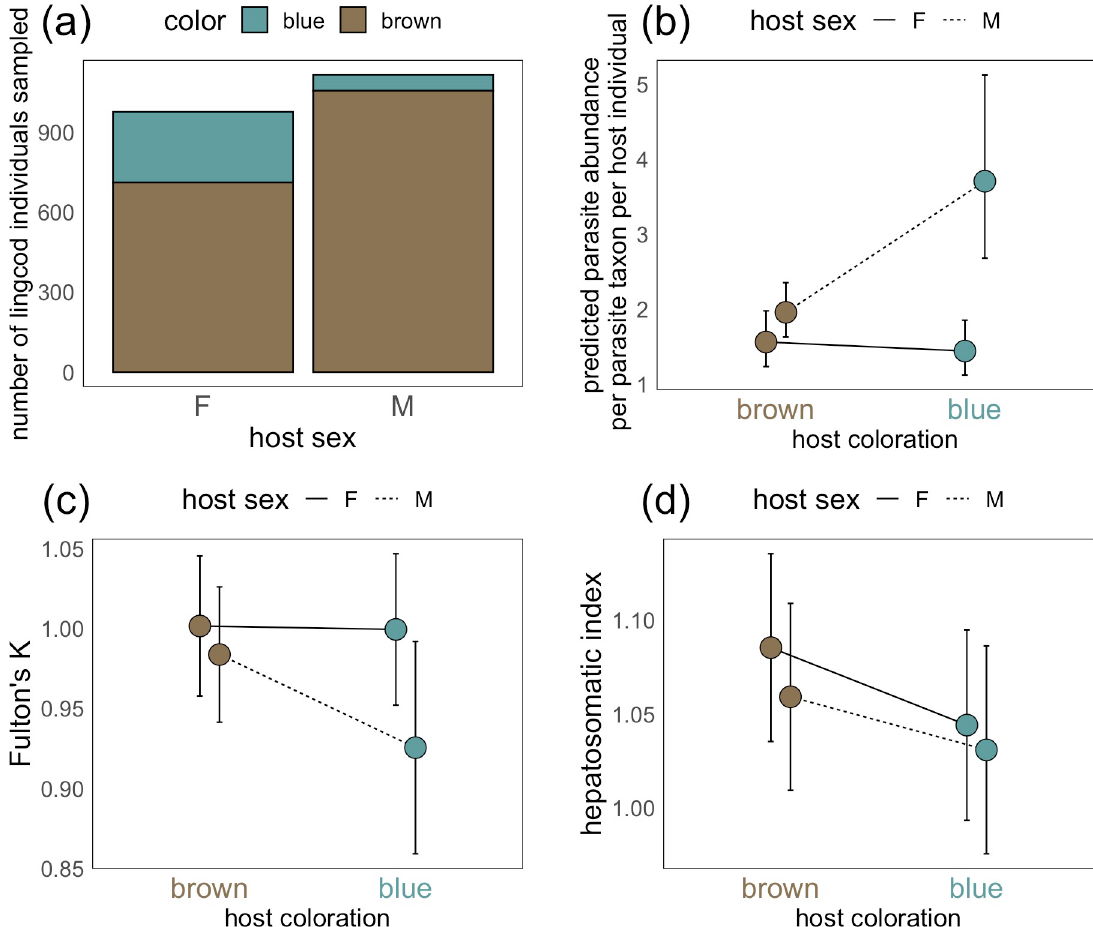
Fig 3. (a) Total number of lingcod individuals sampled of each sex (male versus female) and each color (blue versus brown). Effect of color (blue versus brown) and sex (male versus female) on (a) parasite abundance of the average parasite taxon per lingcod individual, (b) Fulton’s K condition factor (i.e., ratio of weight to cubed length), and (d) hepatosomatic index, where data represent predicted (fitted) values for the response of parasite abundance to color and sex, computed while keeping all other factors (including random effects) in the model constant using the ggeffects() function in the ggeffects package in R [44]. For (b), (c), and (d), points are slightly jittered in the x- dimension to allow visualization of overlapping error bars. females (27.2% blue) than among males (5.4% blue; χ 2 = 186.25, df = 1, p < 0.0001; Fig 3A ). From among this initial group of lingcod collected, we analyzed the metazoan parasite burdens of 89 individuals, including 59 brown males, 4 blue males, 15 brown females, and 11 blue females. In these fish, we detected 29,465 parasite individuals across 25 taxa. A few parasite taxa dominated parasite detections. Specifically, larval trematodes (metacercariae) found in the fin and muscles of lingcod comprised 57% of all parasite detections. The next most abun- dant parasites were the adult trematode Rhipidocotyle elongata (9.8%), the larval acanthoceph- alan (cystacanth) Corynosoma wegeneri (5.8%), and copepod larvae (chalimus stage, 5.0%; S1 Table ). The remainder of the parasite taxa we detected (21 taxa) each comprised fewer than 5% of all parasite detections and included copepods, isopods, monogeneans, trematodes, ces- todes, nematodes, and acanthocephalans ( S1 Table ). Although these 21 taxa comprised only a small proportion of total detections, these parasites still reached high abundances in infected hosts; for example, each of the 36 lingcod infected with cestode larvae (plerocercoids) in the